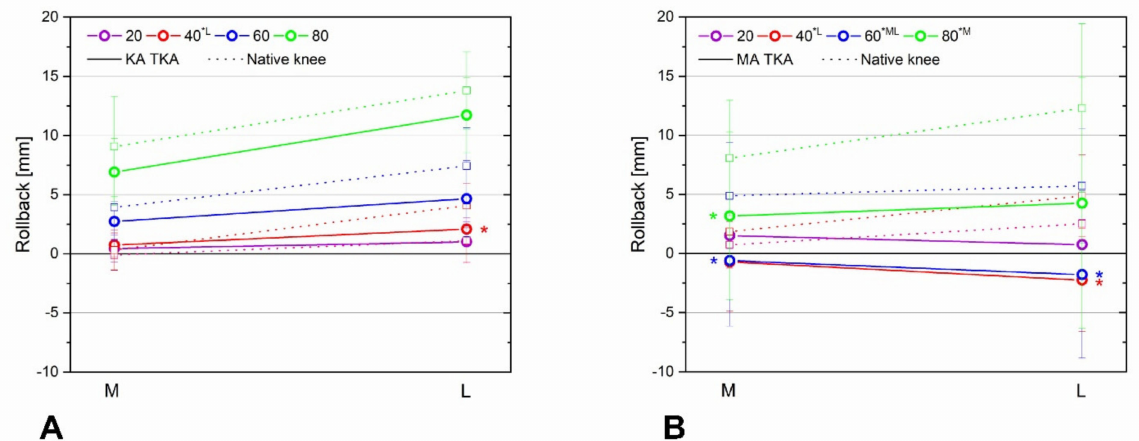
Figure 6. Tibiofemoral axial rotations after KA TKA ( A ) and MA TKA ( B ). During flexion, KA TKA and native knee rotations were similar, while rotation following MA TKA was quite different from that of the native knee. A paradoxical forward movement was observed after MA TKA. Significant differences ( p < 0.05) are marked with asterisks.